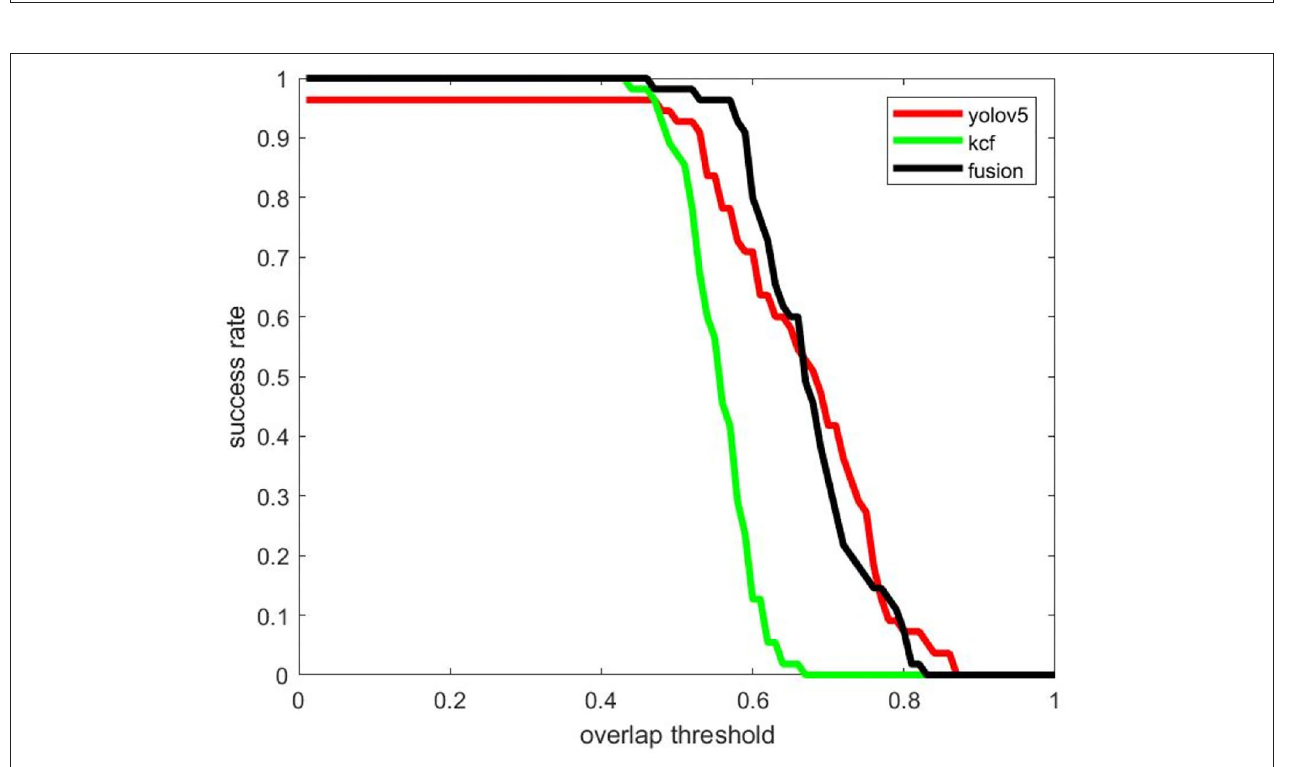
FIGURE 13 | Comparison of detection and tracking success rates using KCF, Yolov5, and fusion algorithms (Video 1).